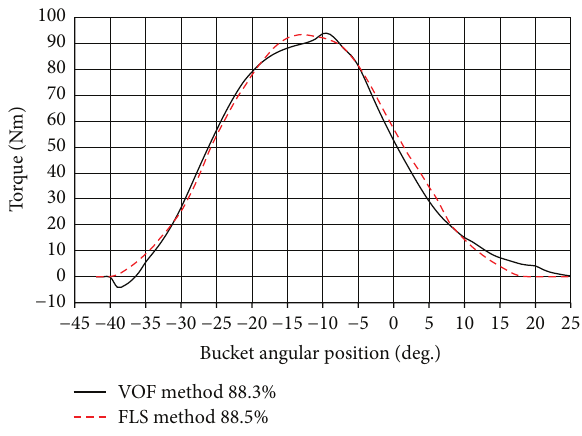
Figure 12: Comparison of the computational results for the refer- ence point.